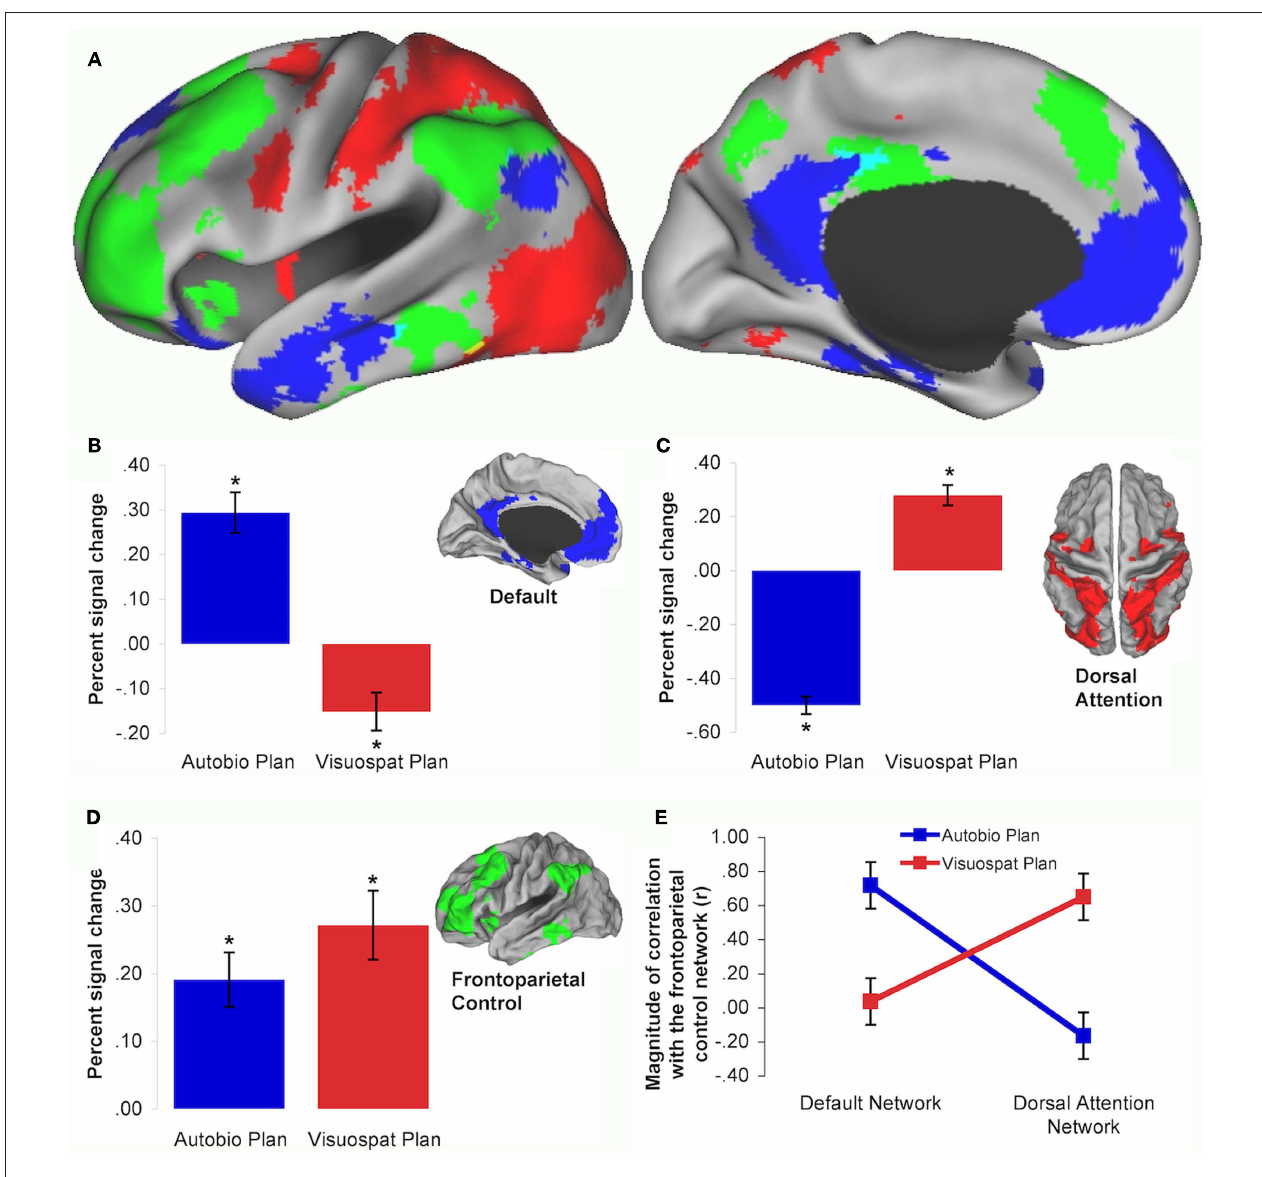
modulated by autobiographical and visuospatial planning tasks. Frontoparietal control network activity is coupled with the default network, and decoupled from the dorsal attention network, during autobiographical planning. Frontoparietal control network activity is coupled with the dorsal attention network, and decoupled from the default network, during visuospatial planning. Data are reproduced from Spreng et